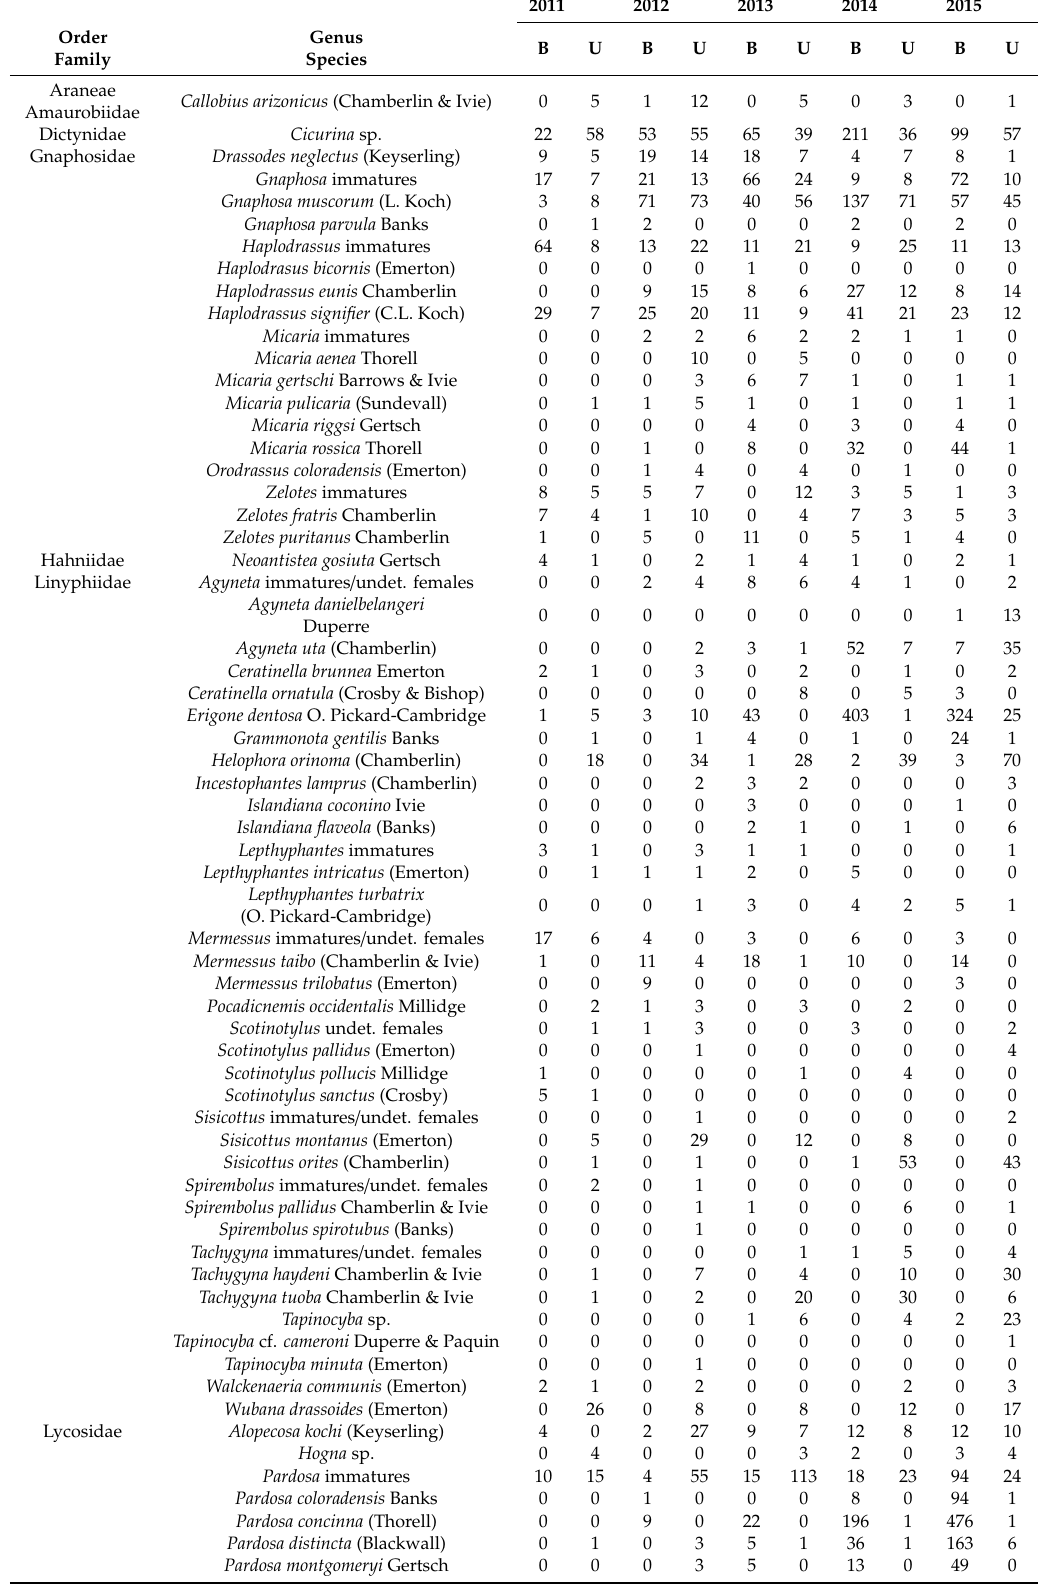
Table A2. Species and numbers collected for Mixed-conifer Forest at Valles Caldera National Preserve 2011–2015. B = burned sites, U = unburned sites. Undet. = undetermined